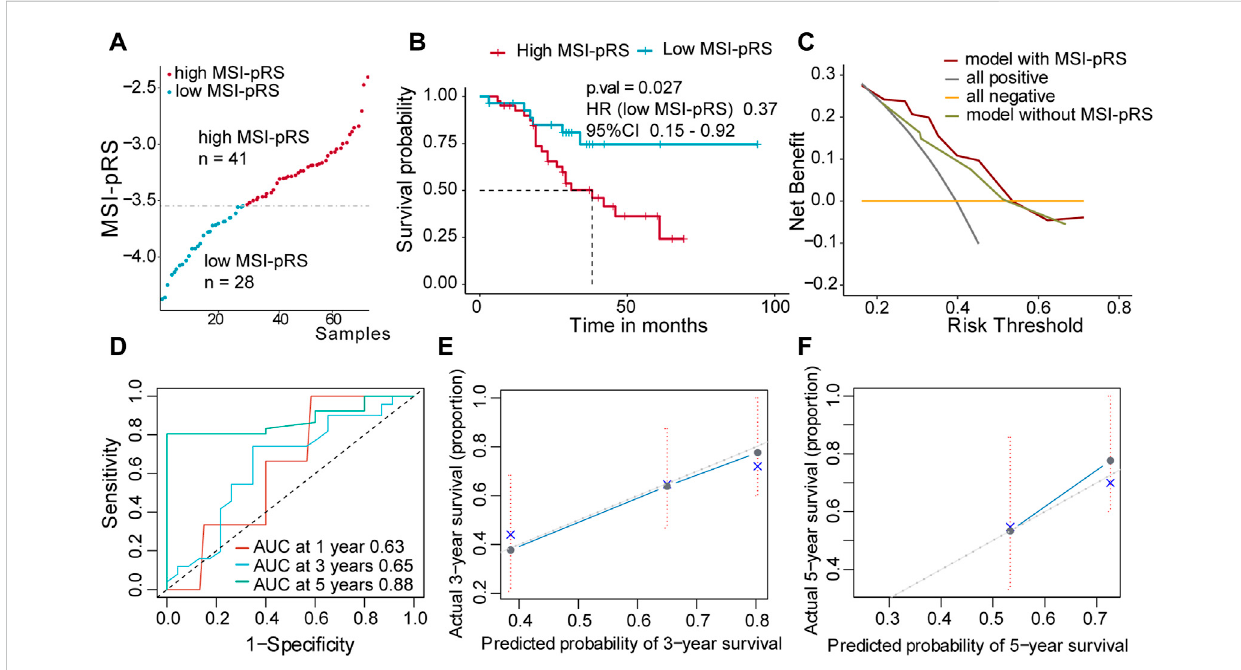
FIGURE 8 Validation of the MSI-related prognostic risk score (MSI-pRS) in the external test cohort (GSE73403 cohort). (A) All patients were divided into MSI- pRS high and MSI-pRS low groups. (B) Kaplan-Meier curves of the MSI-pRS high and MSI-pRS low groups in the external test cohort. (C) Decision curves ofthemultivariateCoxmodelwithorwithoutMSI-pRS.ThemodelwiththeMSI-pRSdeclared abetterperformancethanthemodelwithouttheMSI-pRS group. (D) Receiver operating characteristic (ROC) curves at years 1, 3, and 5 of the model including age, tumor stage, and MSI-pRS group. (E and F) Calibration curves of the model including age, tumor stage, and MSI-pRS